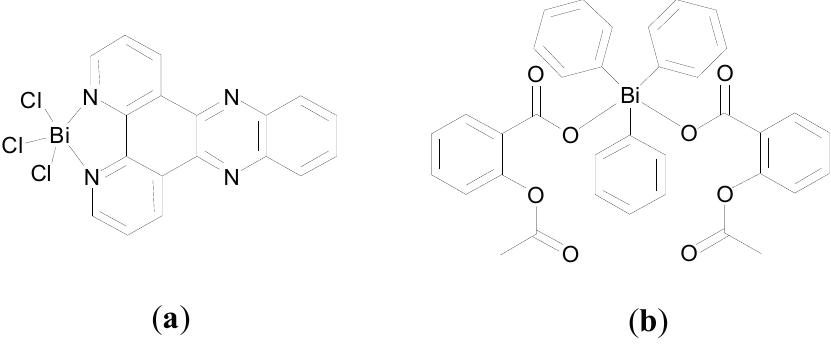
Figure 15. Proposed structures of ( a ) [Bi(dppz)Cl 3 ] and ( b ) [Ph 3 Bi(AcSA) 2